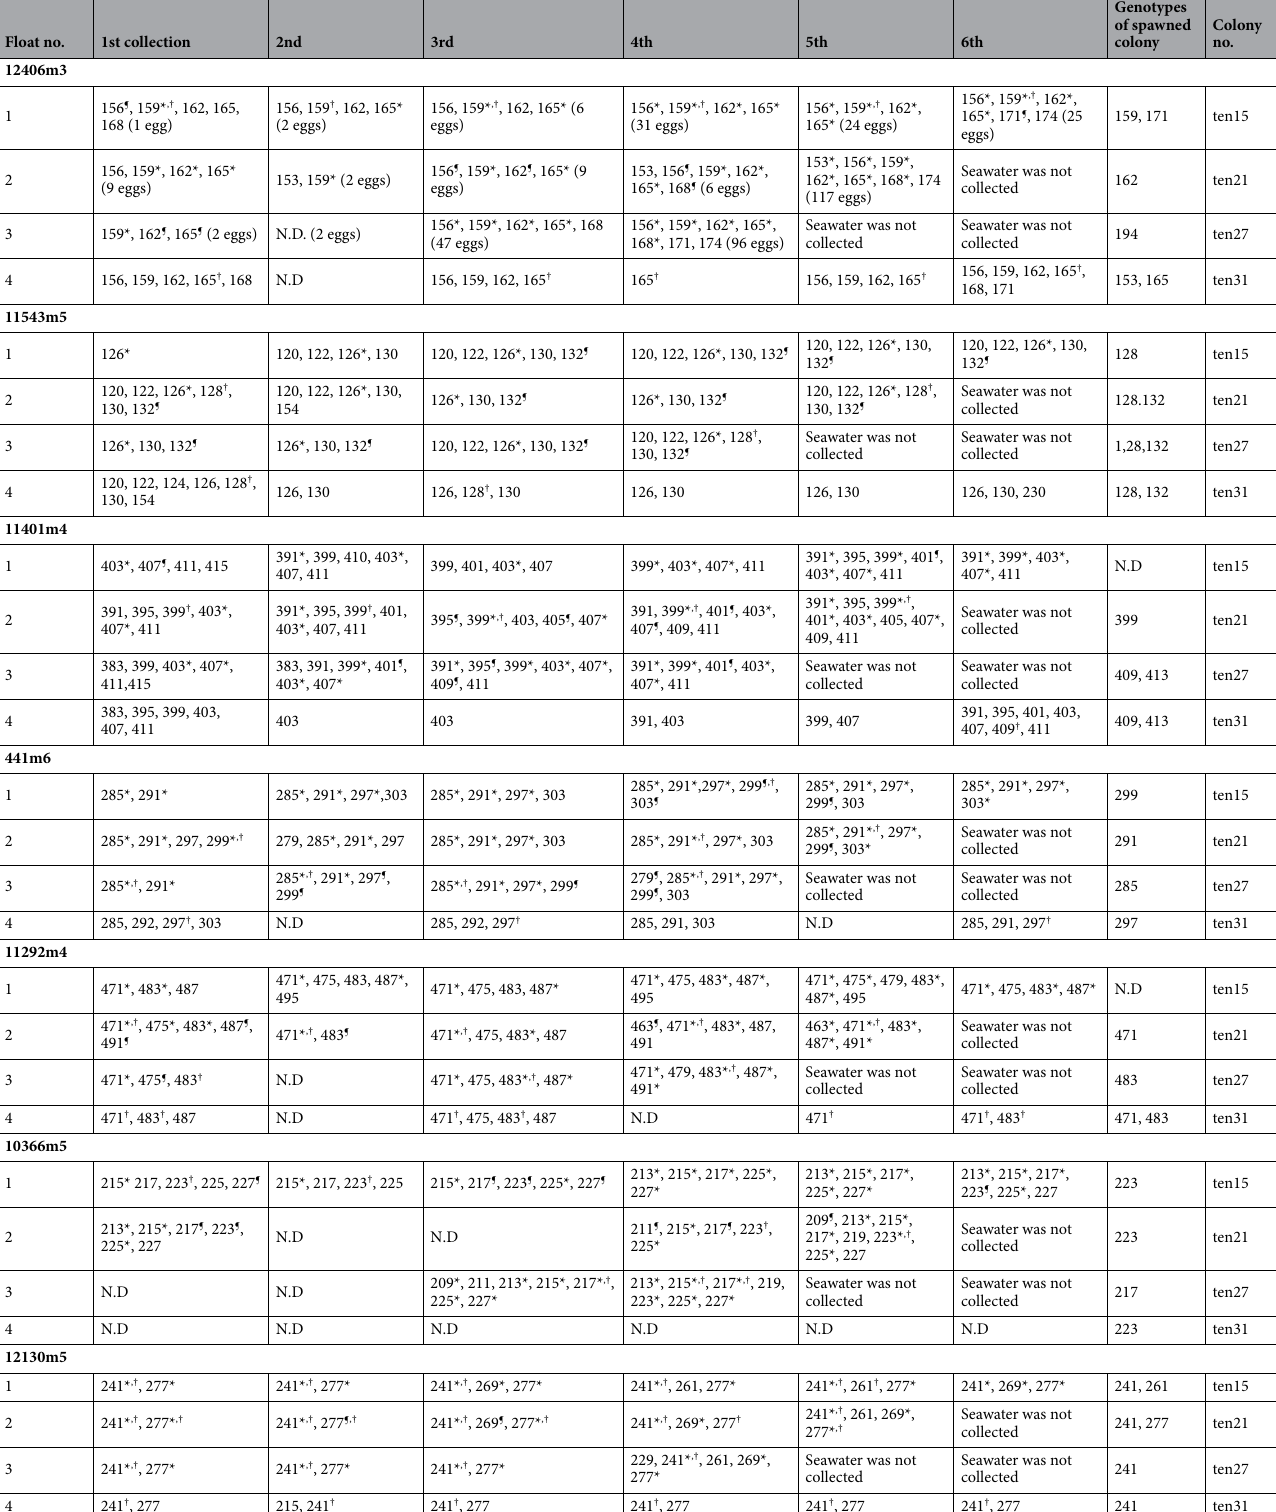
Table 1. Alleles detected in seawater and fertilized egg samples. *Alles found in both fertilized eggs and sperm, ¶ Alleles found only in fertilzed eggs, † Alleles from tagged colony, alleles without mark was found only in